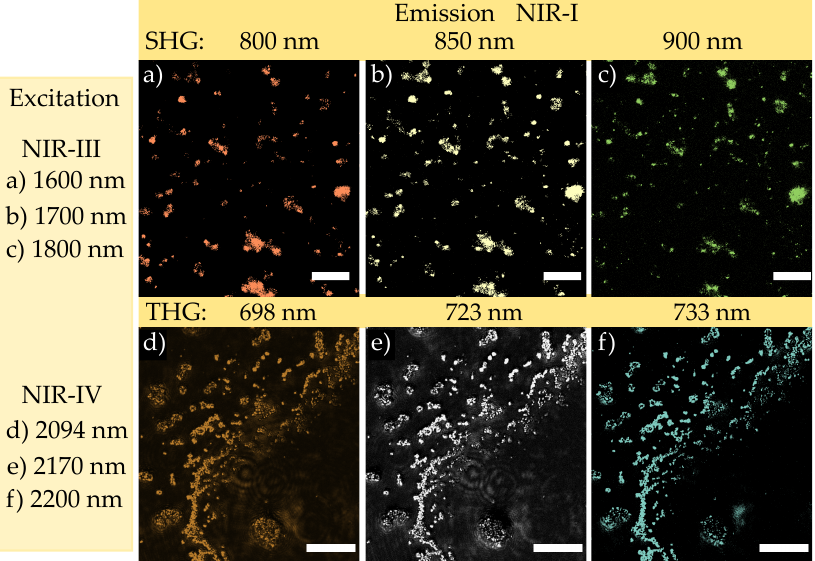
Figure 3. Nonlinear images acquired from nanoparticles dried on a coverslip using the TIGER microscope. NIR-III/NIR-I configuration using SHG: ( a ) 1600/800 nm ( b ) 1700/850 nm ( c ) 1800/900 nm. NIR-IV/NIR-I configuration using THG: ( d ) 2094/698 nm ( e ) 2170/723 nm and ( f ) 2200/733 nm. Scale bar is equal for all pictures to 20 µ m. Images are presented in